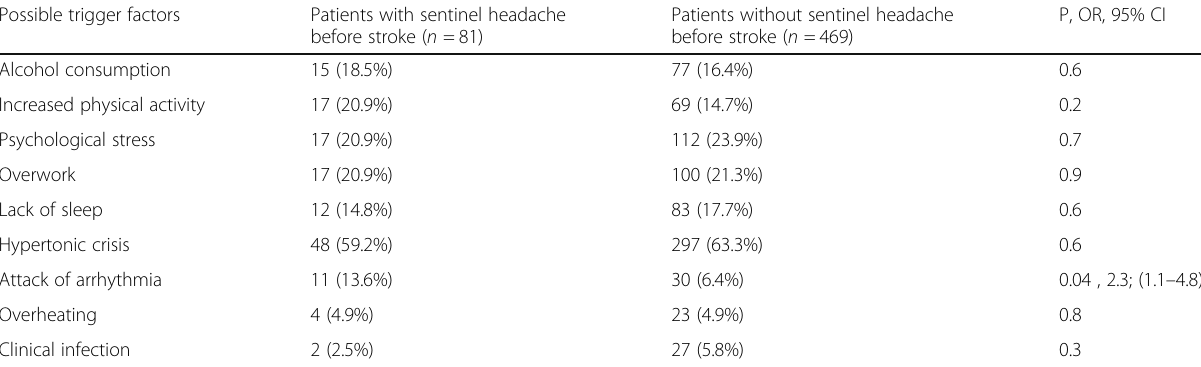
Table 5 Possible trigger factors in patients with and without sentinel headache during 1 week before stroke Possible trigger factors Patients with sentinel headache Patients without sentinel headache before stroke ( n = 81) before stroke ( n =